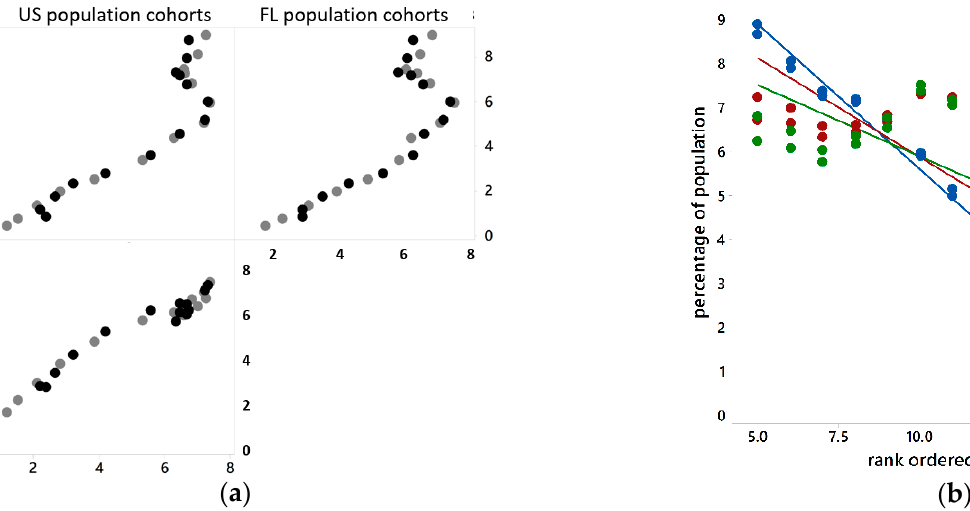
Figure 3. Scatterplots of reference population distributions, ages 20+. Left ( a ): paired by age cohorts; black denotes male, grey denotes female. Right ( b ): ordered by age cohorts; blue denotes World, red denotes US, and green denotes Florida (FL).